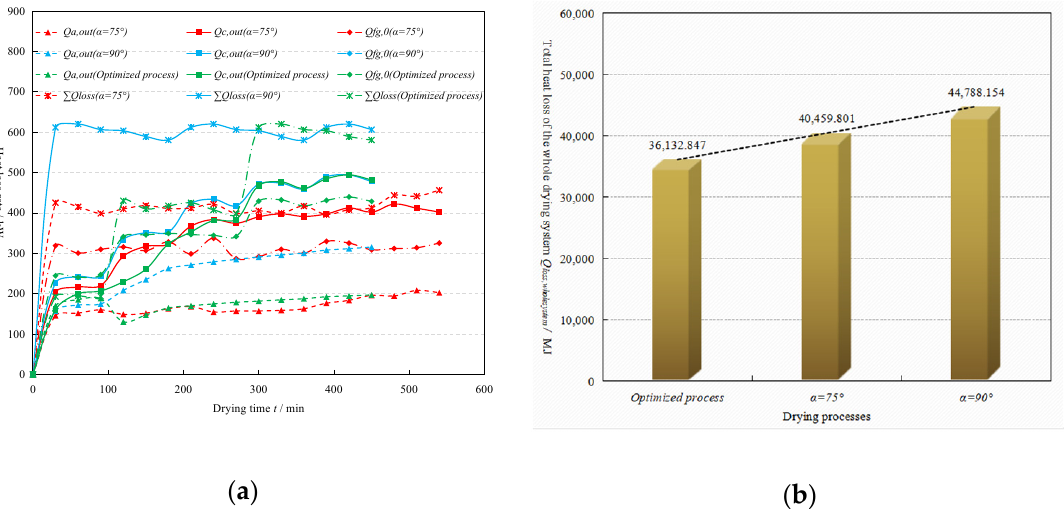
Figure 6. The heat loss characteristics ( a ) and the total heat loss ( b ) of the drying system for the three drying processes.